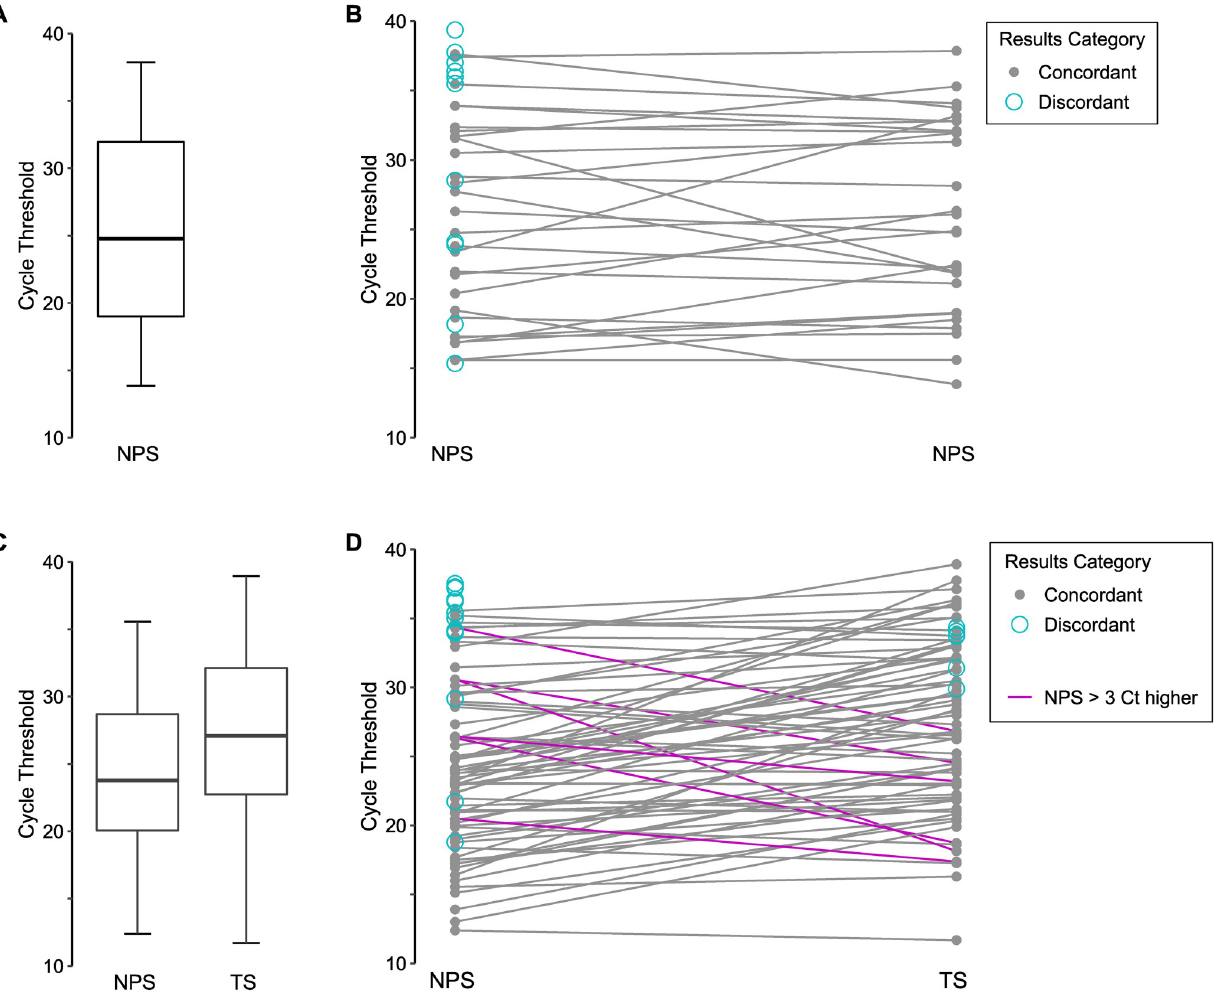
Fig 3. Comparison of envelope (E) gene rRT-PCR cycle threshold (C t ) values for individuals with multiple same-day specimens collected. C t values are analyzed by episodes for which there were multiple nasopharyngeal swabs (NPS) collected, or a combination of throat swab (TS) and NPS. C t is plotted by results category which indicates that the same-day specimens were both positive (concordant), or had a positive specimen and negative specimen (discordant). (A) Boxplot with median C t for all same-day collected nasopharyngeal swabs (NPS) with concordant results, (B) C t across same-day collected NPS pairs, (C) boxplot with median C t for same-day collected NPS and throat specimens with concordant results, (D) C t across same-day collected NPS and throat specimen pairs. Paired NPS + throat specimens for which the NPS was > 3 C t higher than the throat specimen are shown as pink